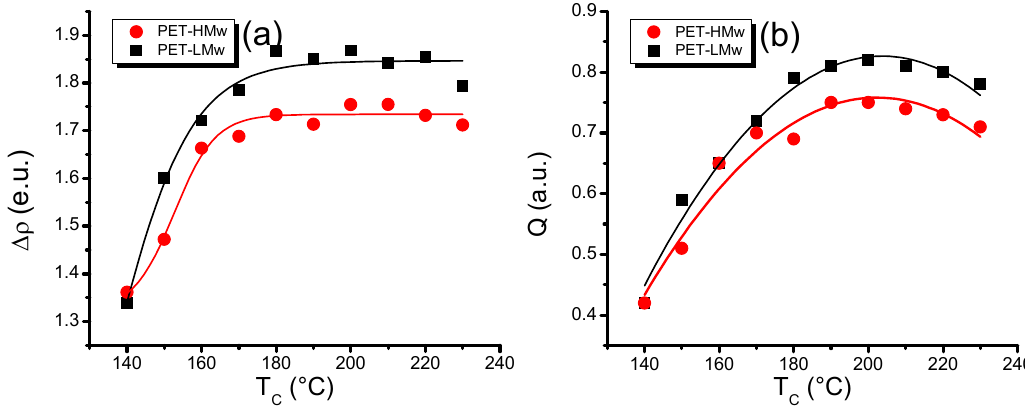
Figure 11. ( a ) Differences in electron density ( ∆ρ ); and ( b ) Invariant ( Q ) of isothermally crystallized PET at different temperatures.